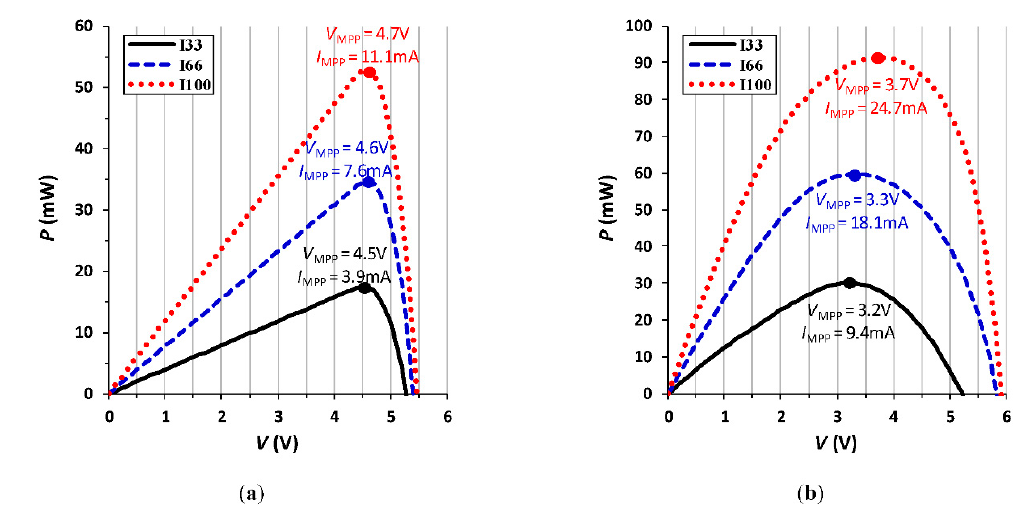
Figure 2. Power-voltage curves of the commercial low-power PV modules: ( a ) PV-1; ( b ) PV-2.